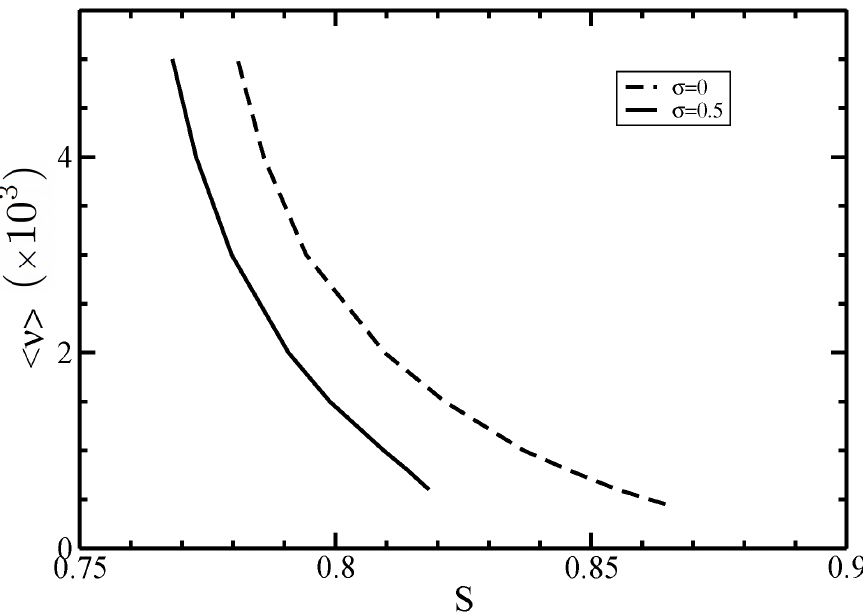
Figure 8. The nematic order parameter S at the I–N phase coexistence for different average lengths < ν > . The normalized standard deviation are σ = 0 (dashed line) and 0.5 (solid line).